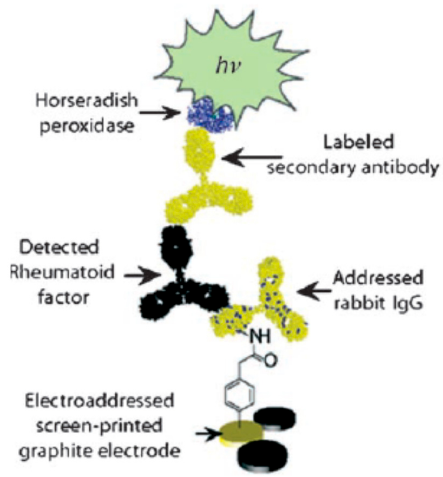
Figure 17. A sandwich immunoassay for the detection of rheumatoid factor. From Reference [104] with permission of Wiley.